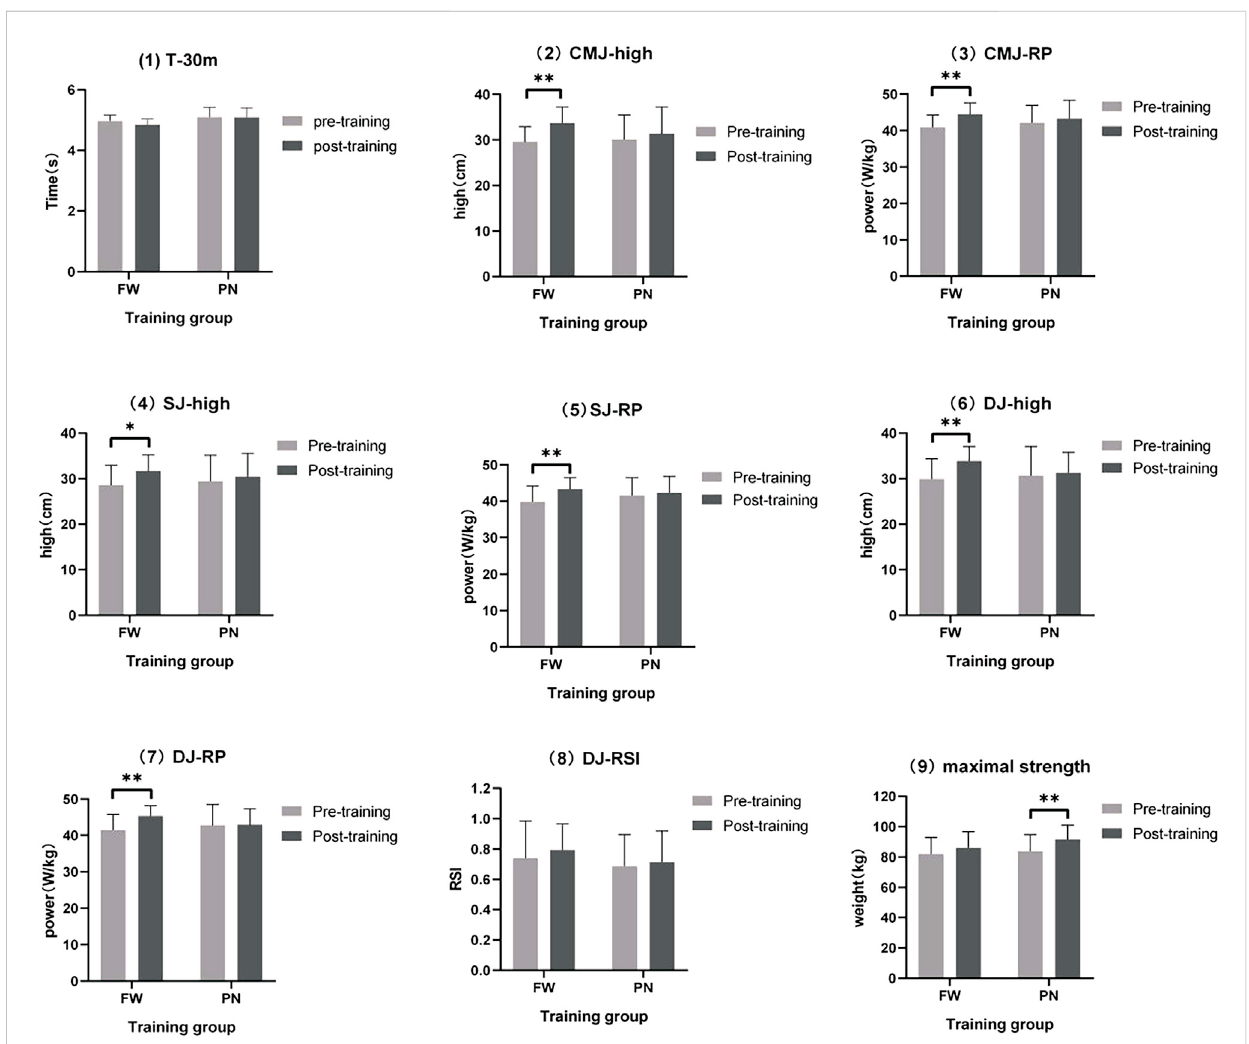
FIGURE 4 Mean changes in T-30M, CMJ-high, CMJ-RP, SJ-high, SJ-RP, DJ-high, DJ-RP, DJ-RSI, and maximal strength after 6 weeks of training. *Signi fi cant difference before and after ( p < 0.05); **very signi fi cant difference before and after ( p <